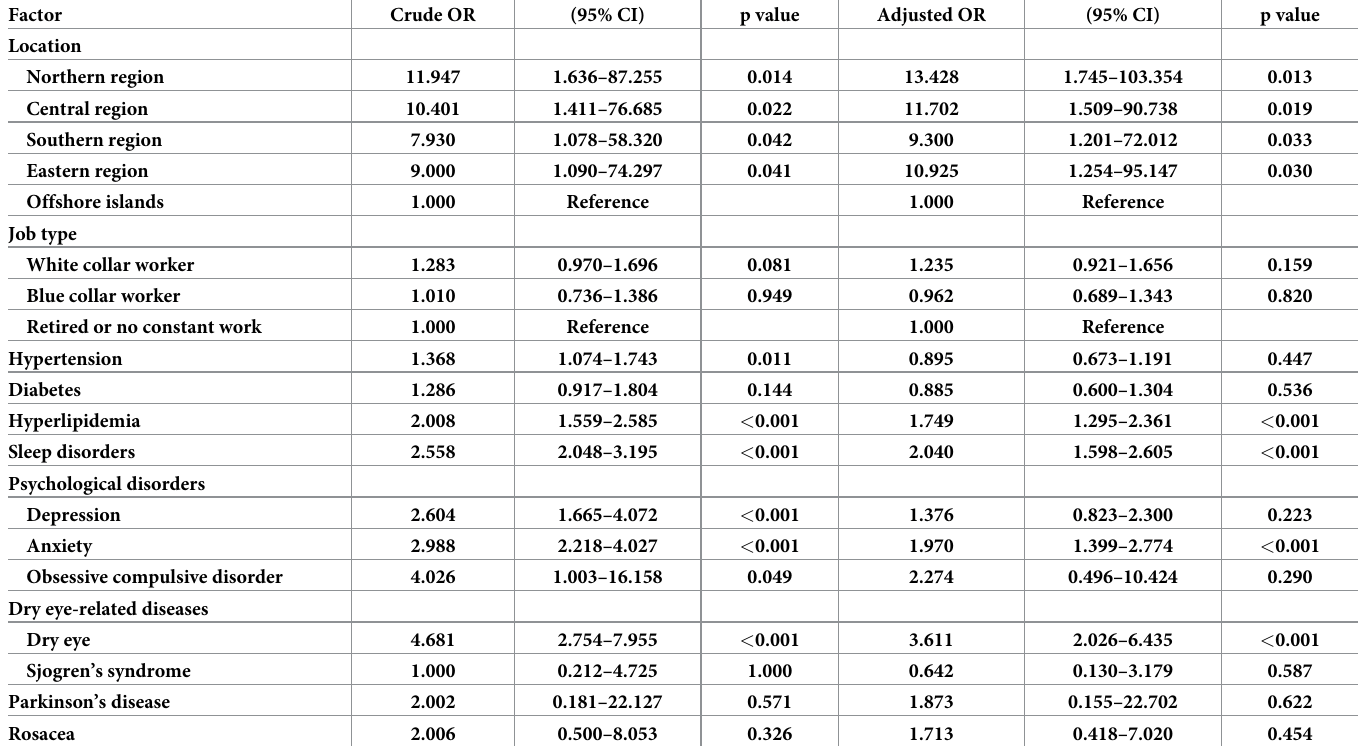
Table 4. Crude and adjusted odds ratios for benign essential blepharospasm among male cases and